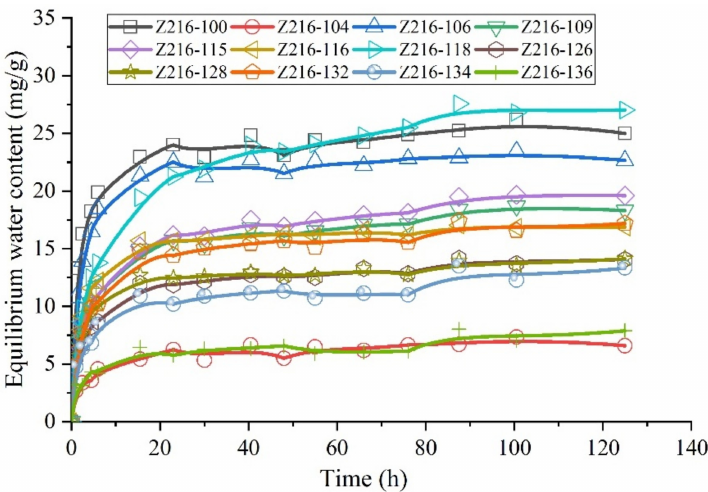
Figure 3. Water adsorption curves of the studied deep shales in the Luzhou